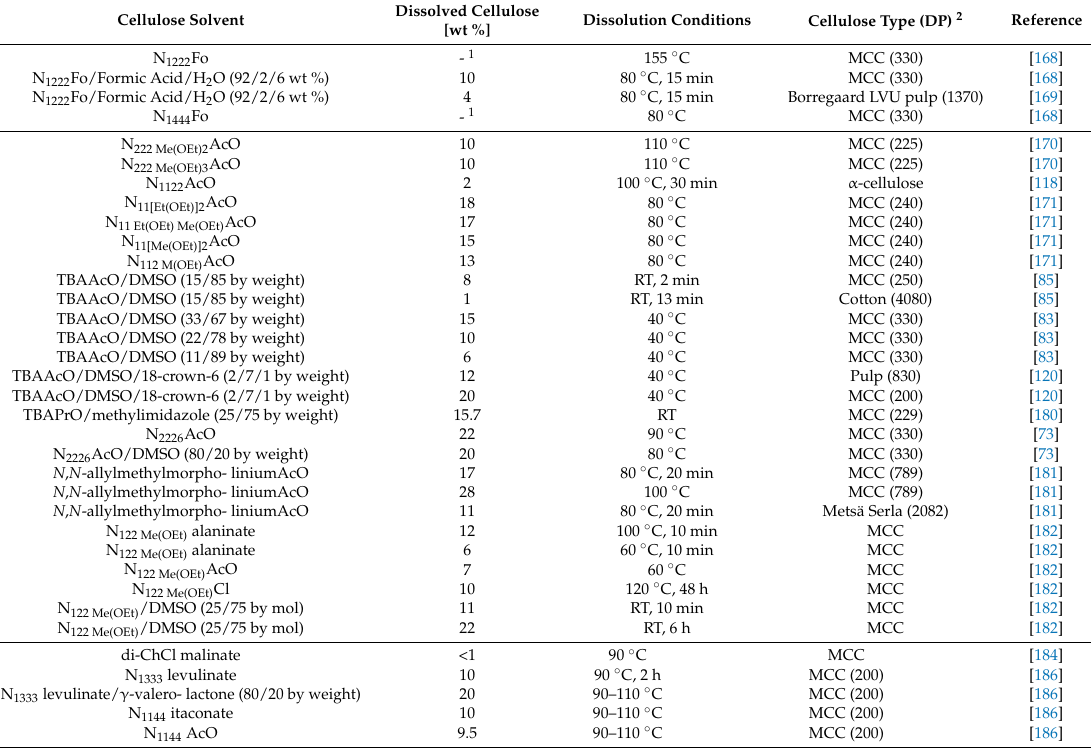
Table 2. Examples of the solubility of cellulose in quaternary ammonium